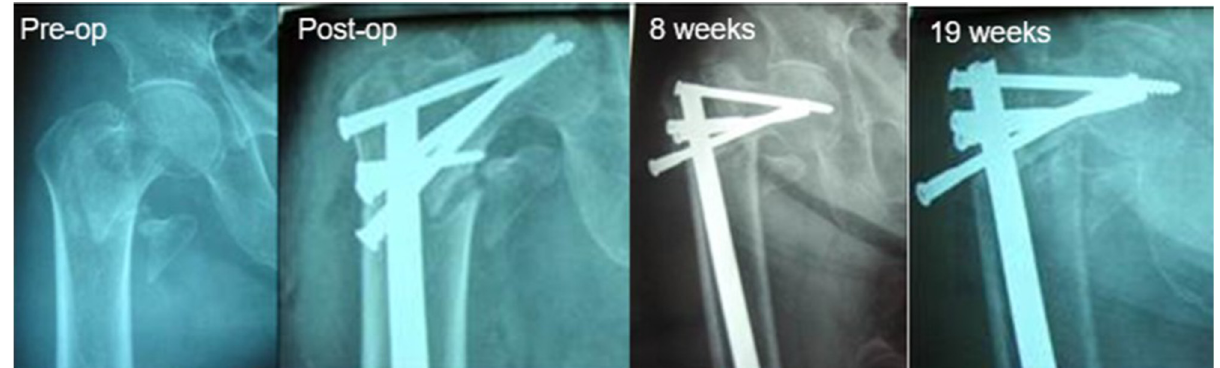
Figure 3. Radiographs of an 80 year old woman who experienced varus collapse but had painless full weight bearing at 8 weeks after surgery.